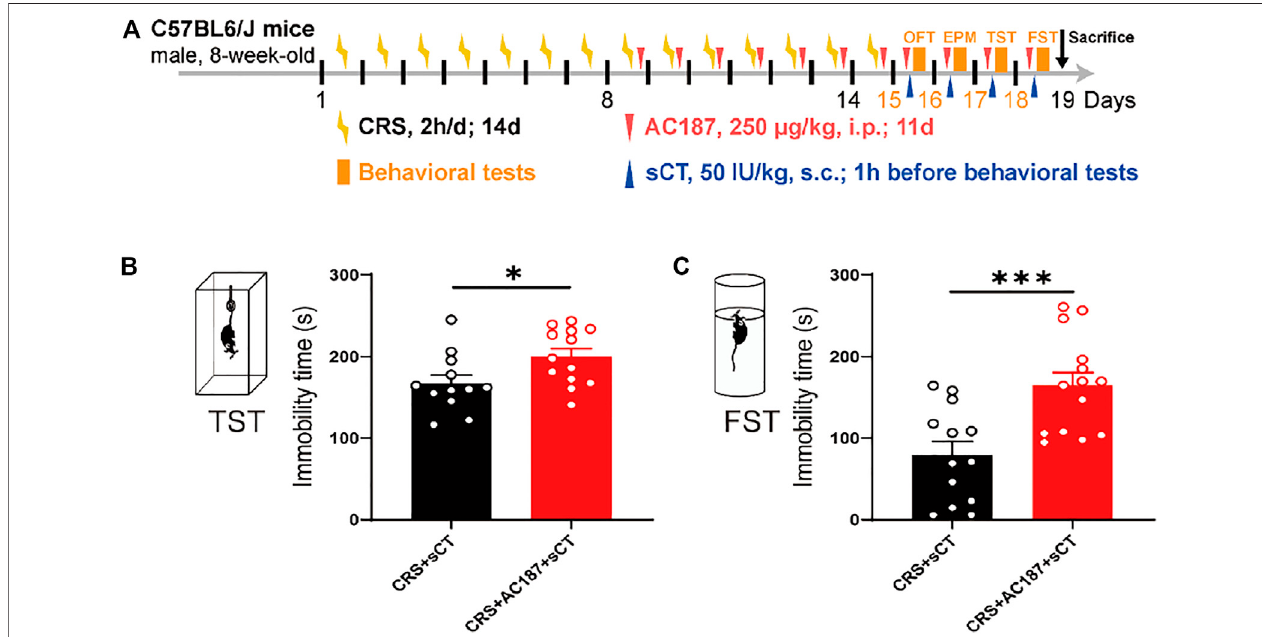
FIGURE7| sCTexertedanantidepressanteffectinCRSmicebyactivatingAMYR.TimelineofCRSexposure,sCT,AC187administration,andbehavioraltests (A) . In TST, when AMYR was inhibited by AC187, the antidepressant effect of sCT was blocked (CRS + sCT: n = 12; CRS + sCT + AC187: n = 13) (B) . In FST, the antidepressant effect of sCT was blocked when the AMYR inhibitor AC187 was administered (CRS + sCT: n = 13; CRS + sCT + AC187: n = 14) (C) . The data were analyzed by unpaired t -test. *p < 0.05, ***p < 0.001. sCT, salmon calcitonin; CRS, chronic restraint stress; AMYR, amylin receptor; TST, tail suspension test; FST, forced swimming test.